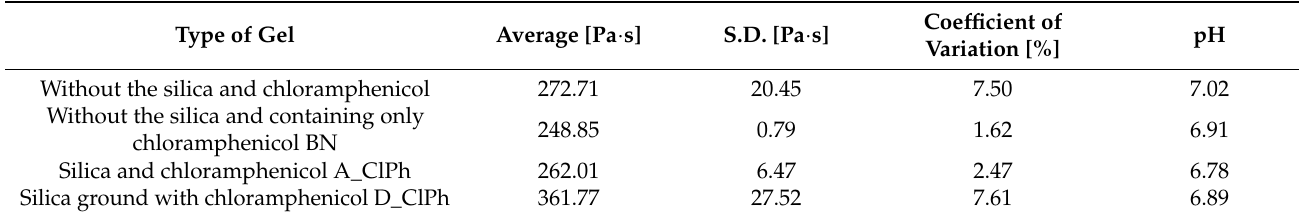
Table 5. Statistical summary of the apparent viscosity measurements and the pH of gels.